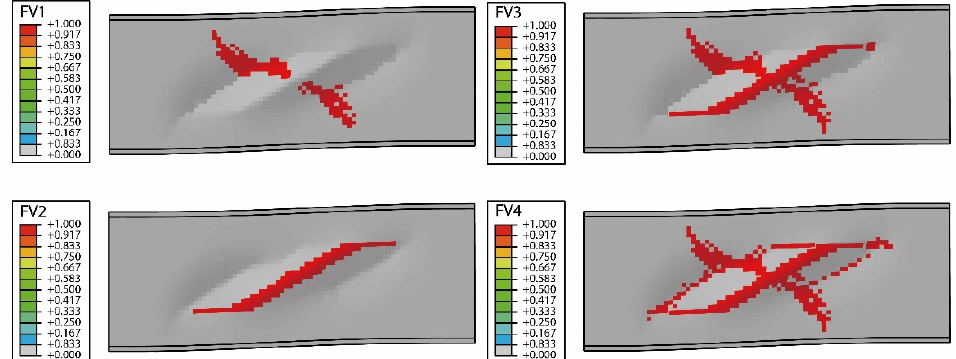
Figure 28. The calculate damage states of the surface ply in the composite beam of BW-I after the final collapse under shear load.